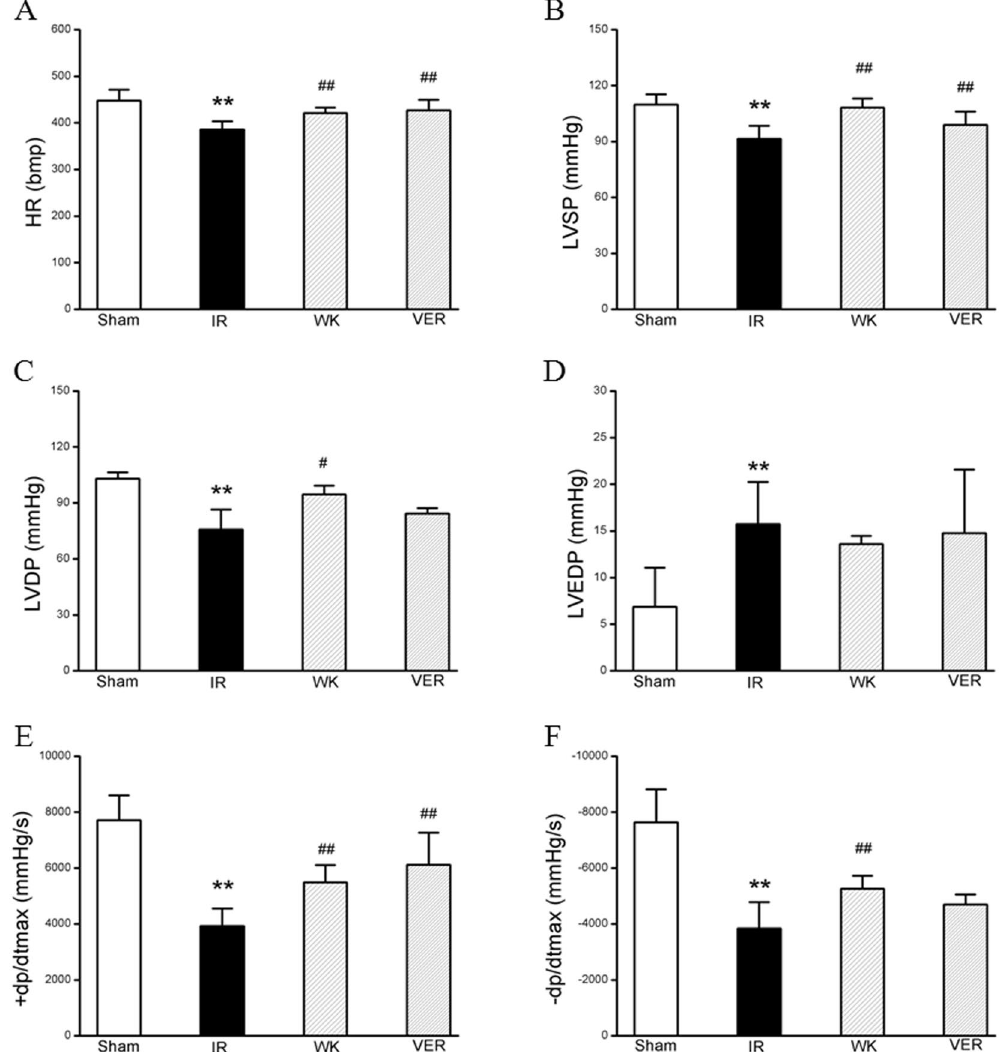
Figure 2. Effects of WXKL and verapamil on hemodynamics post I/R injury. Quantitative hemodynamic assessment was carried out on the left ventricle through right carotid artery to evaluate the role of WXKL or verapamil for I/R injury. ( A ) heart rate (HR), ( B ) left ventricular systolic pressure (LVSP), ( C ) left ventricular development pressure (LVDP), ( D ) left ventricular end diastolic pressure (LVEDP), ( E ) left ventricular maximum upstroke velocity ( + dp / dt max ), and ( F ) left ventricular maximum descent velocity ( − dp / dt max ). Data are expressed as means ± S.D.; ** p < 0.01 compared with sham group; # p < 0.05, ## p < 0.01 compared with model